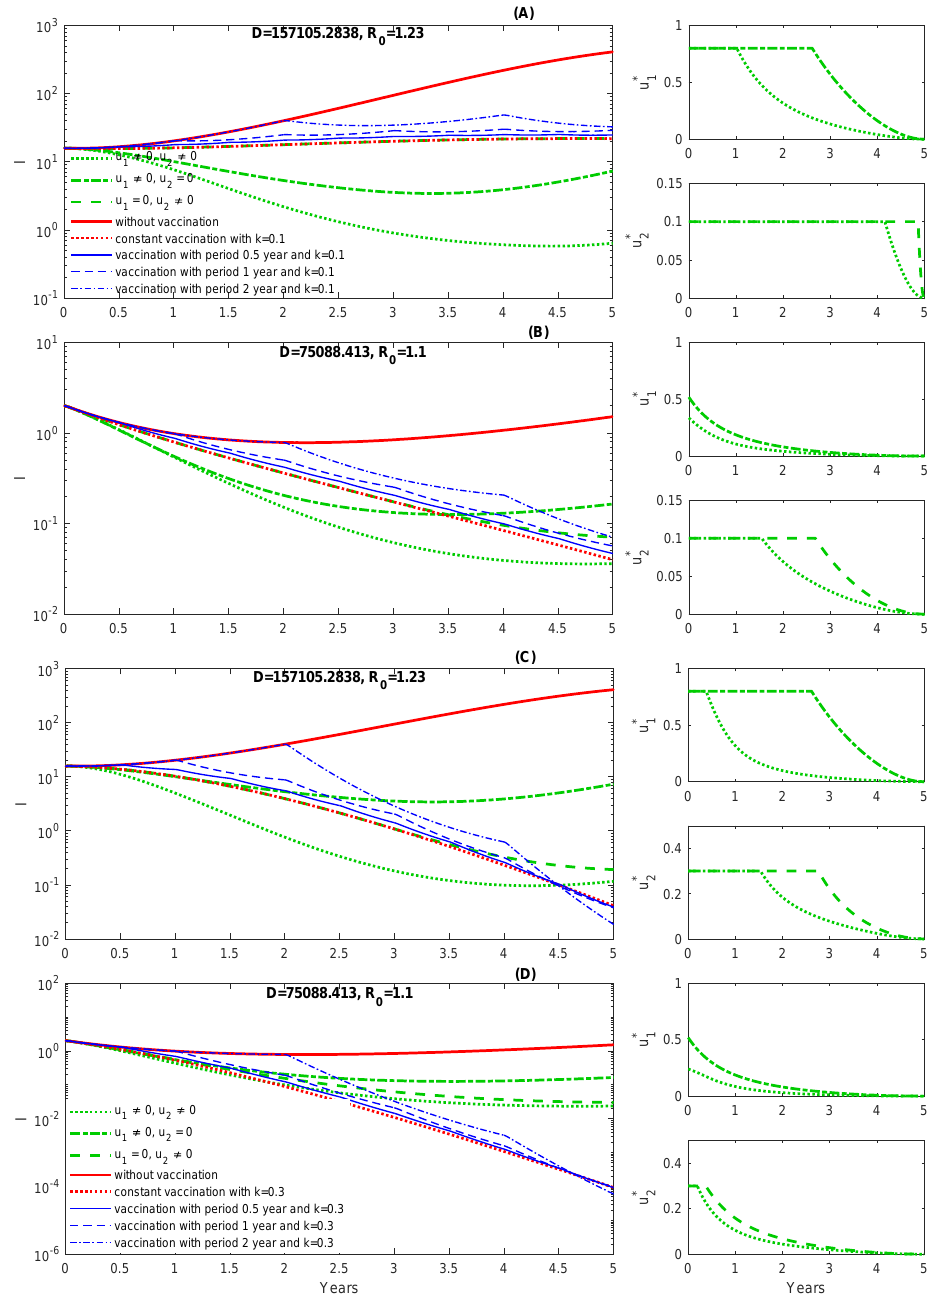
Figure 3. Different types of control strategies are compared for ( A ) vaccination coverage, k = 0.1 and basic reproduction number R 0 = 1.23, ( B ) k = 0.1, R 0 = 1.1, ( C ) k = 0.3, R 0 = 1.23, and ( D ) k = 0.3, R 0 = 1.1. The corresponding optimal control strategies are presented on the right most column of each